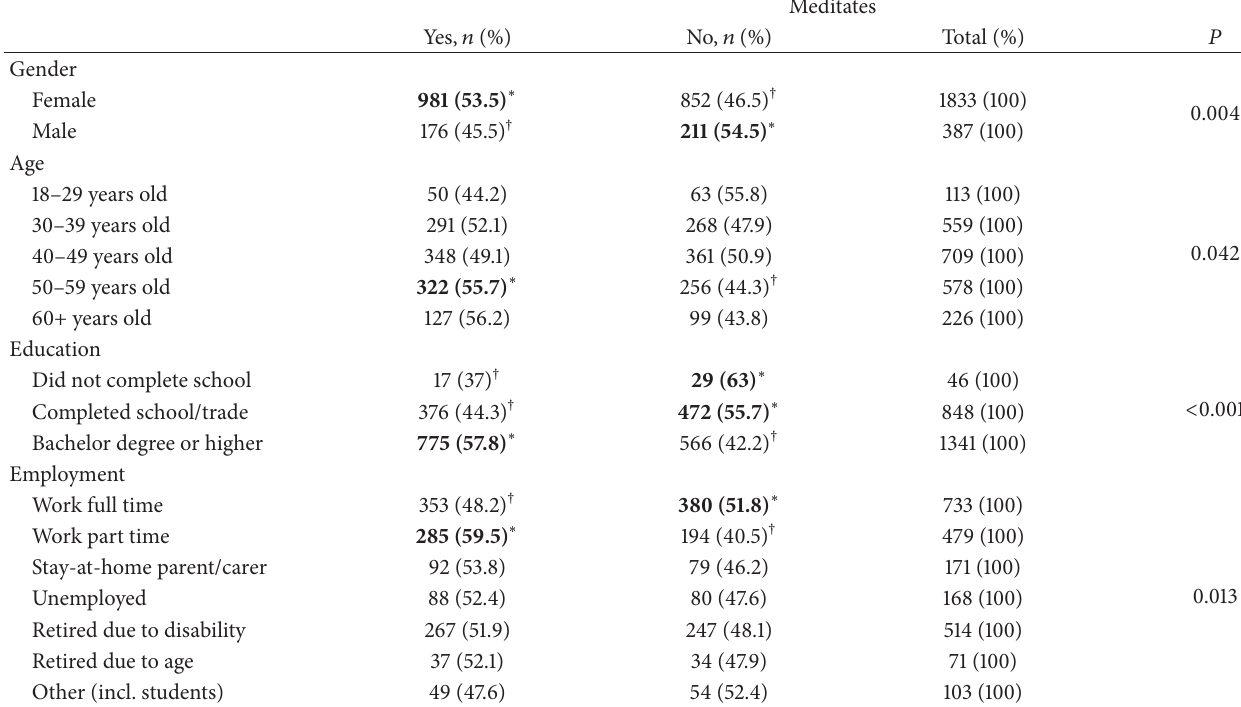
Table 1: Summary of demographics comparing those who meditated in the last 12 months to those who did